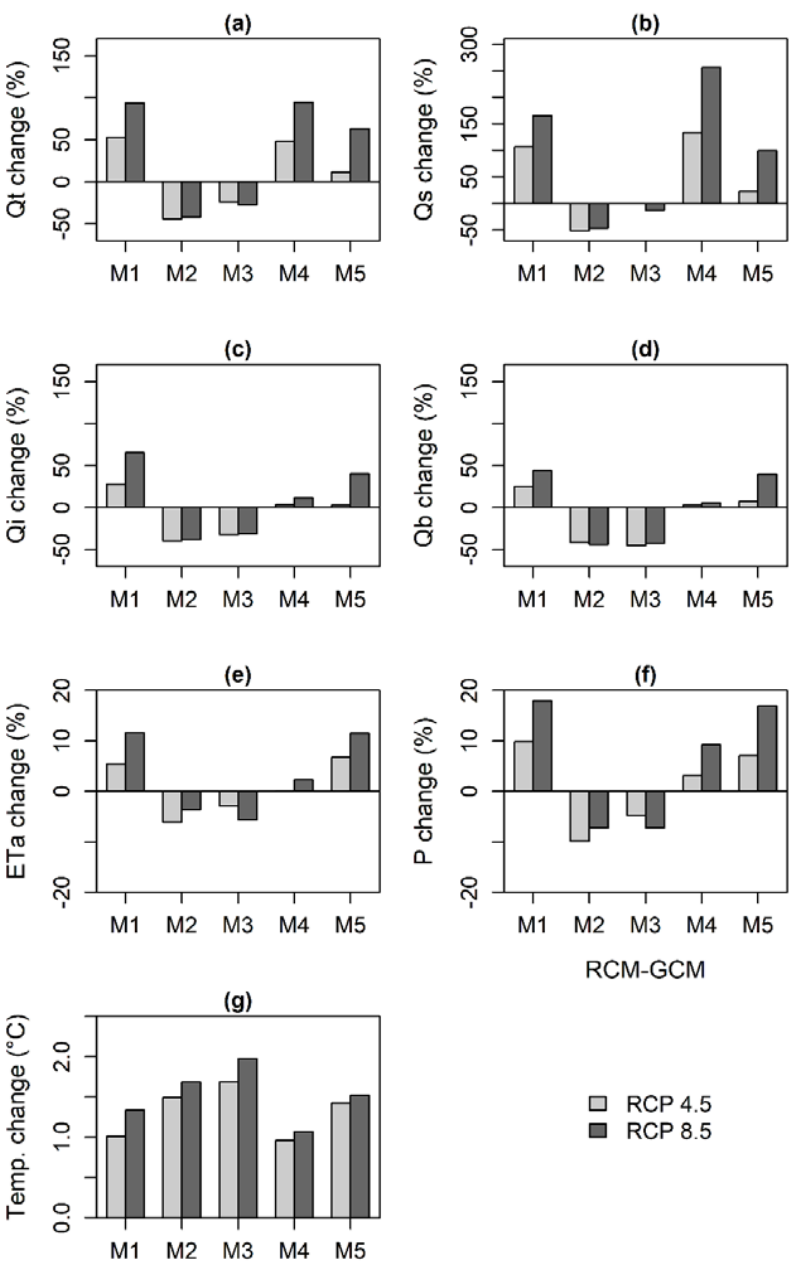
Figure 8. Annual change of air temperature (Temp.) and precipitation (P) in the period of 2021–2050 and the subsequent change of actual evapotranspiration (ETa), total runoff (Qt), surface runoff (Qs), interflow (Qi), and base flow (Qb) compared to the period of 1971–2000 (LU-2013 was employed for both reference and prediction periods): M1 : CCLM-CNRM; M2 : CCLM-EARTH; M3 : CCLM-ESM; M4 : HIRHAM-NorESM; and M5 : RACMO-EARTH. ( a ): total runoff; ( b ): surface runoff; ( c ): interflow; ( d ): base flow; ( e ): actual evapotranspiration; ( f ): precipitation; and ( g ): temperature.